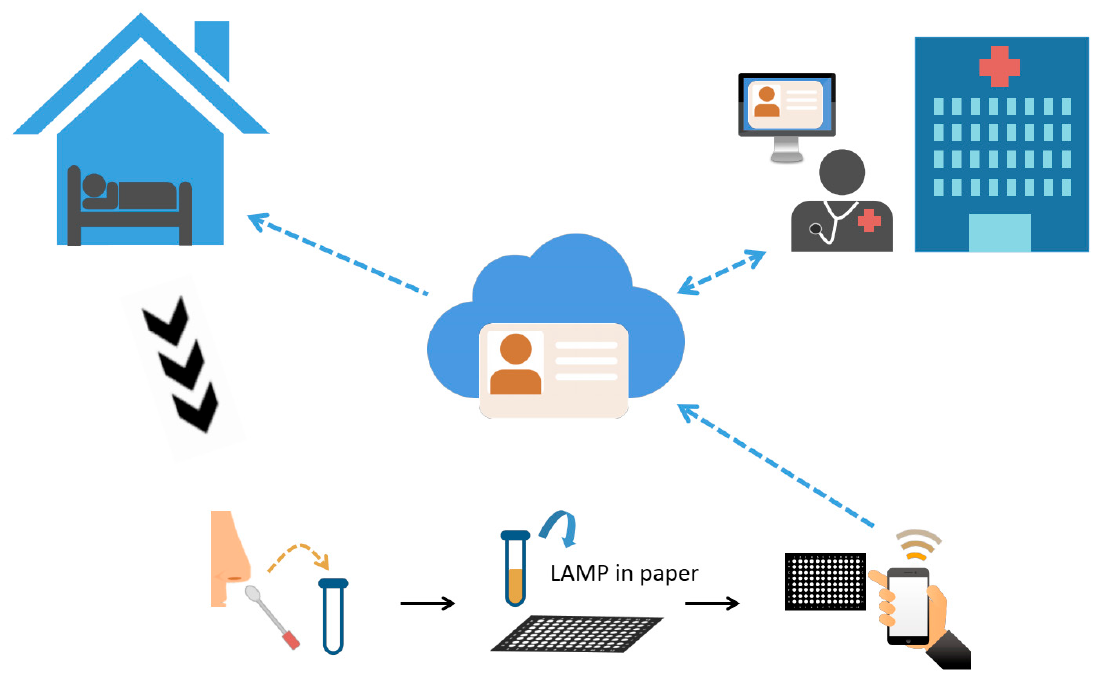
Figure 1. Schematic of the point-of-care (POC) RNA-based novel coronavirus disease (COVID-19) diagnostic device. In this figure, the conceptual workflow of integrating both point-of-care diagnostic and loop-mediated isothermal amplification (LAMP) assay with mobile device was presented. People at home quarantine can collect their infectious specimen through nasal swab; after adding specific reagents for LAMP reaction, the colorimetric result can be observed on paper. By recording the colorimetric change through a mobile phone camera, the user could upload the result to cloud storage by Internet. Clinicians or health-care specialist could thus analyze the result and offer immediate information for both patient and the government. Since the whole diagnostic process can be performed at home, the suspected case does not need to travel to hospital and can in turns lower the risk of spreading the disease.